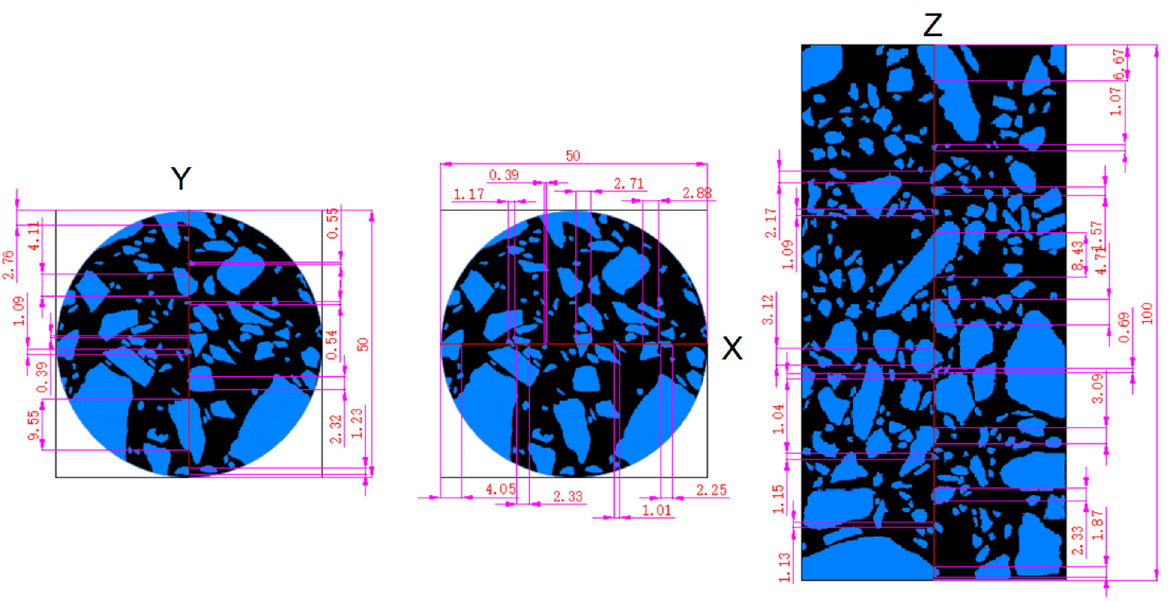
Figure 9. Schematic diagram of the marking the length of coarse aggregate.